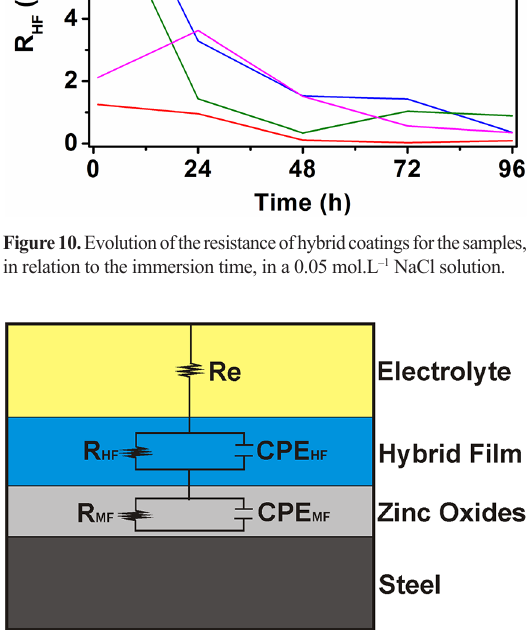
Figure 11. Physical model of the studied samples, presenting the general hybrid film, zinc oxide and